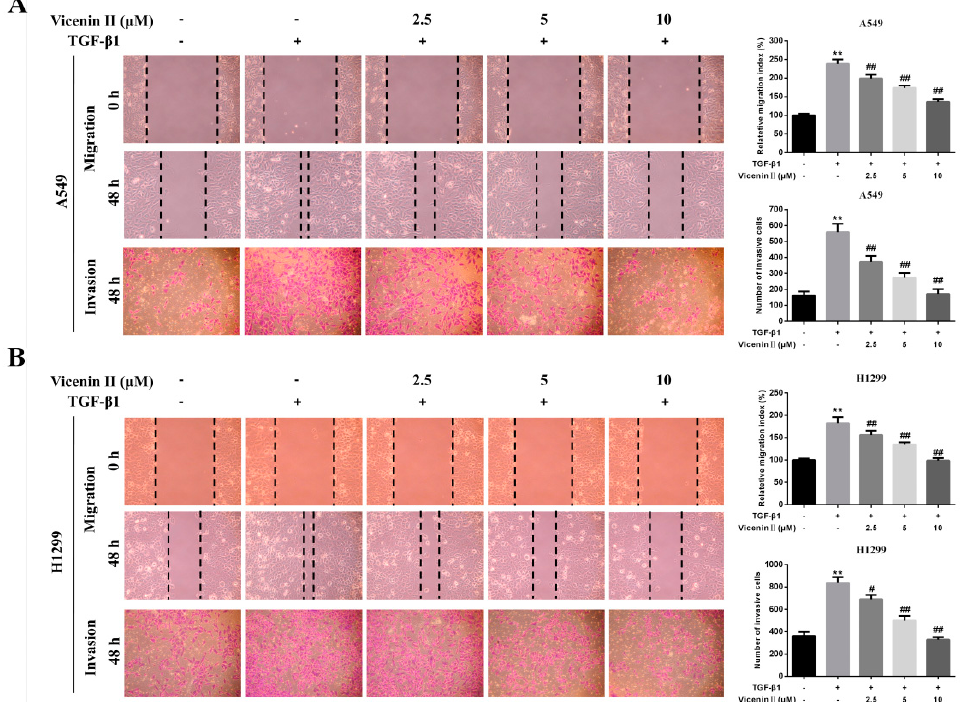
Figure 4. ViceninII inhibited TGF- β 1-induced migration and invasion of ( A ) A549 and ( B ) H1299 cells. Cells were treated with TGF- β 1 (5 ng/mL) for 48 h and co-treated with ViceninII (2.5, 5 and 10 µ M) for the last 24 h. The migration and invasion capacities were measured by the wound healing and transwell assays. Typical graphs and a histogram (mean ± SD) are shown, n = 3. Magnification is × 100. ** p < 0.01 compared with the control group; # p < 0.05, ## p < 0.01 compared with the TGF- β 1-treated